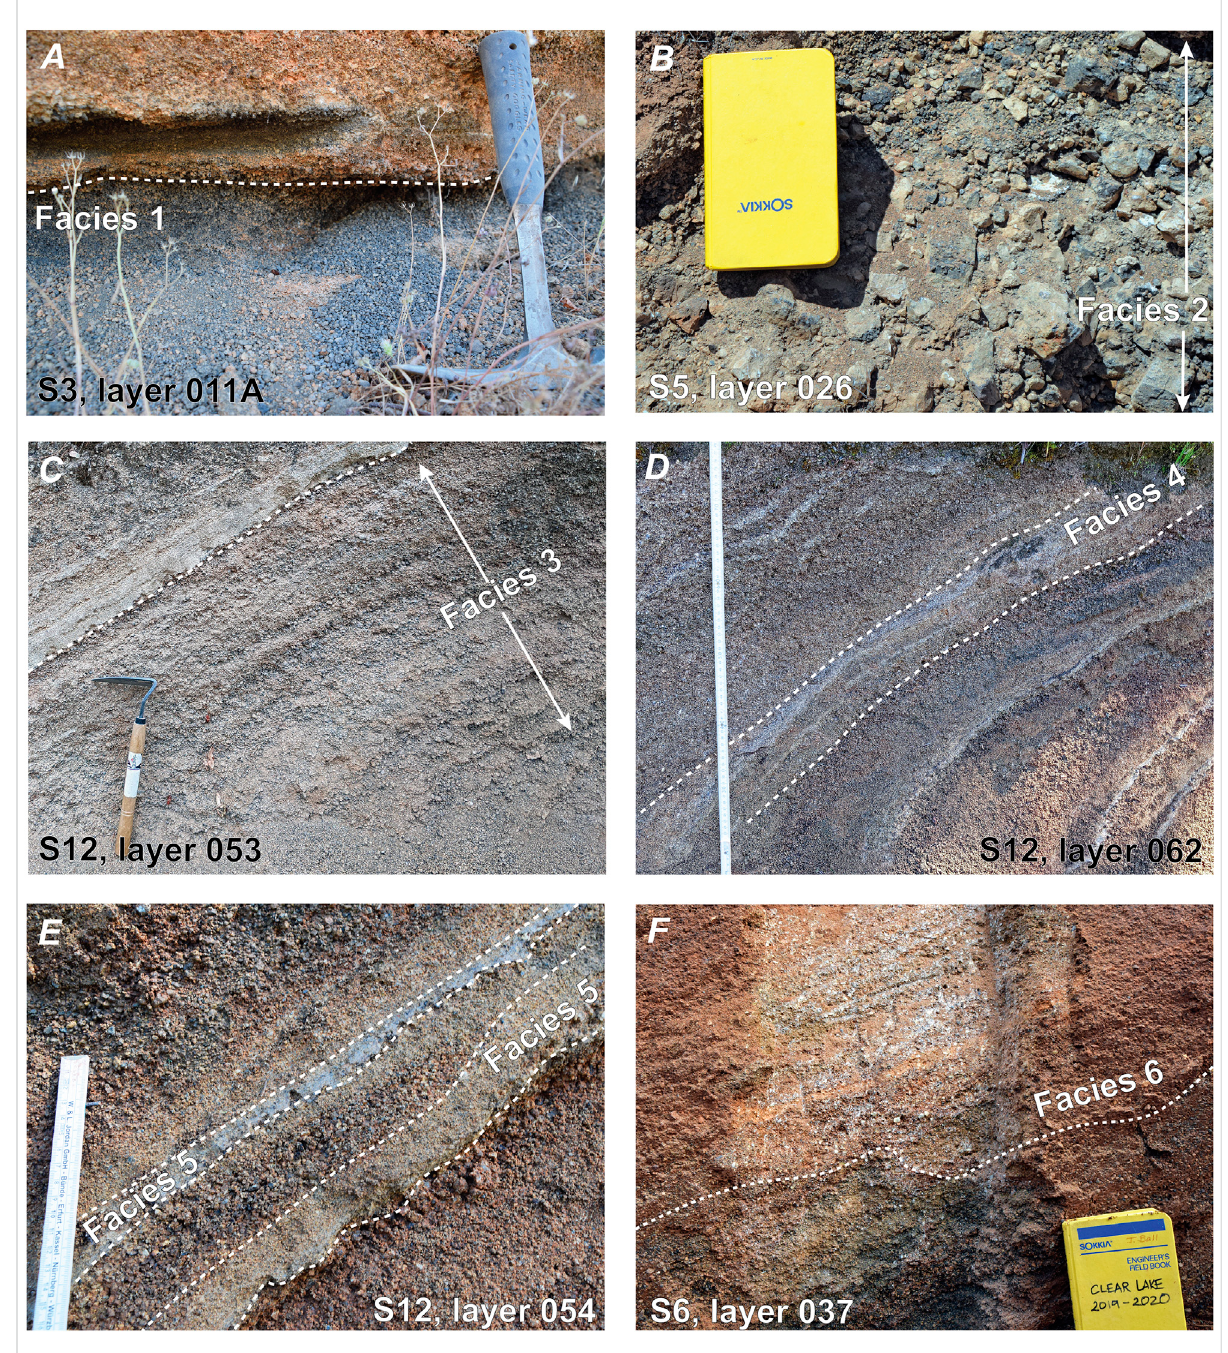
FIGURE 4 Examples of maar facies. (A) Facies 1, S2, layer 011A. This facies is often totally unconsolidated and eroded into undercuts. (B) Facies 2, S5, layer 026,showingsigni fi cantlylargerclaststhanthelayersabove. (C) Facies3,S12,layer053,showinganintervalofatleast fi vereverse-gradedlayers. (D) Facies 4, S12, layer 062; ashy layers with clear laminations. (E) Facies 5, S12, layer 054. Ashy layers lacking laminations, but with irregular bases underlain by thin carbon layers. (F) Facies 6, S6, layer 037. Massive ungraded juvenile lapilli, with brighter clasts having been sliced open